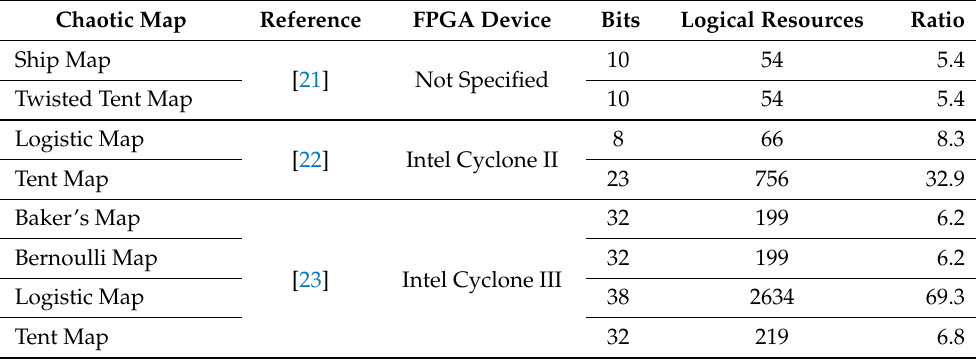
Table 3. Comparing logical components of chaotic maps across